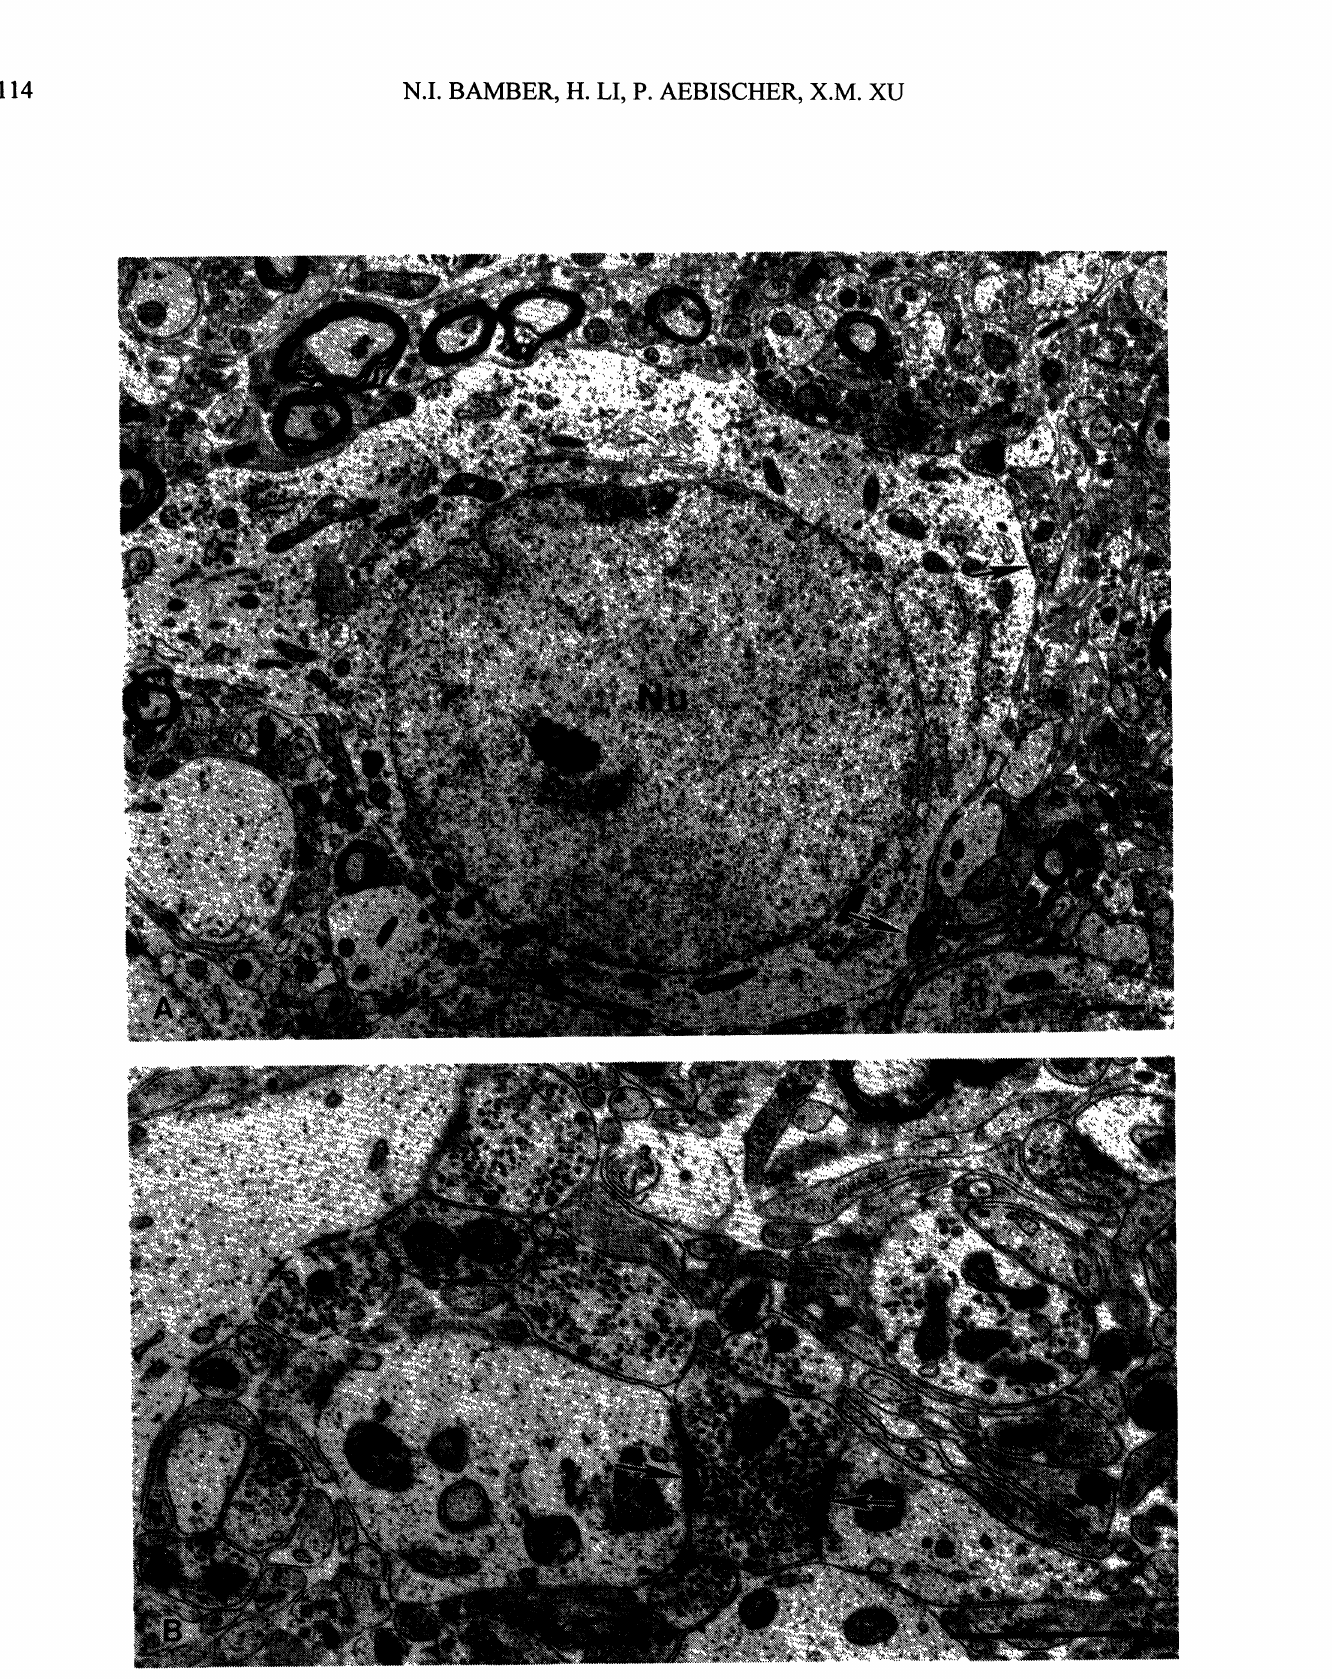
Fig. 7: A: Electron photomicrograph showing the CNS-like environment within a FSC graft. As might be expected, neurons (Nu) are found within these CNS-like regions. Note that axo-somatic synapses (,) are fotmd on a neuron. B: Numerous synaptic contacts were observed within the CNS-like graft tissue. All Bars: